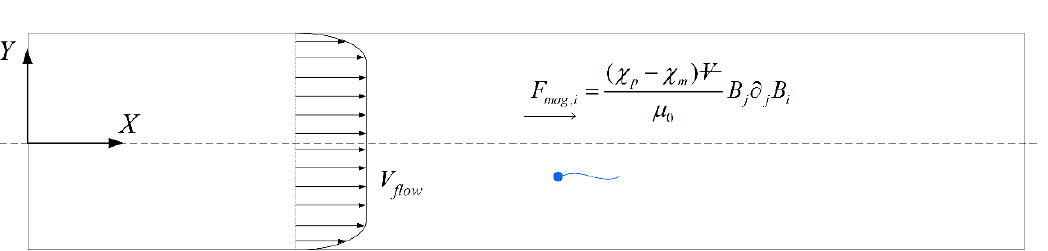
Figure 5. Sperm in 2D channel heading in the negative X -direction, subjected to magnetic force and a flow in the positive X -direction.